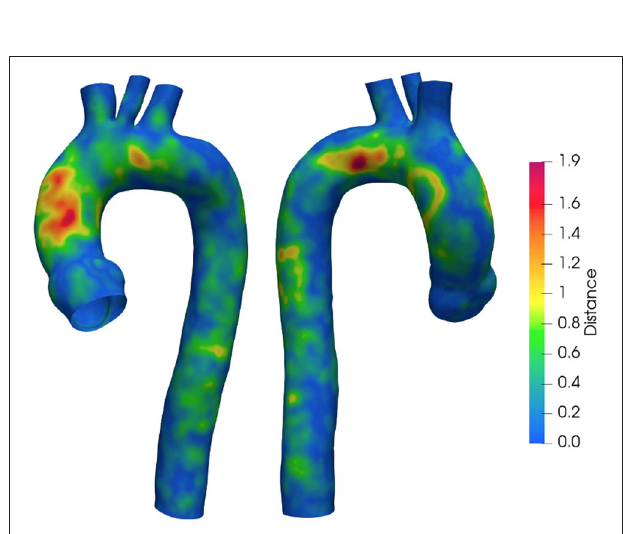
FIGURE 4 | Geodesic distance between geometries with S L and S H . Values are in